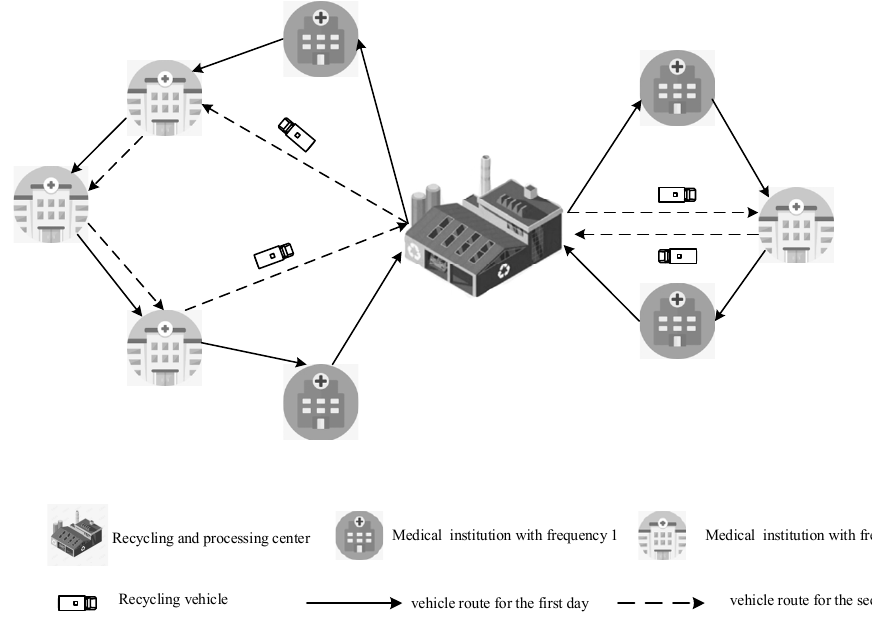
Figure 1. Example of a medical waste recycling problem.